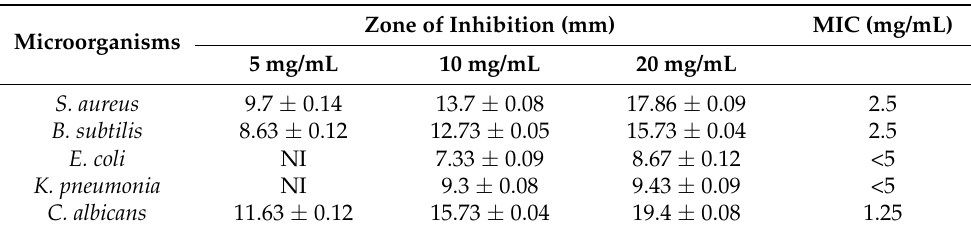
Table 2. Zone inhibition (mm) and Minimum Inhibitory Concentration (MIC) analysis of P. crispum leaves essential oil